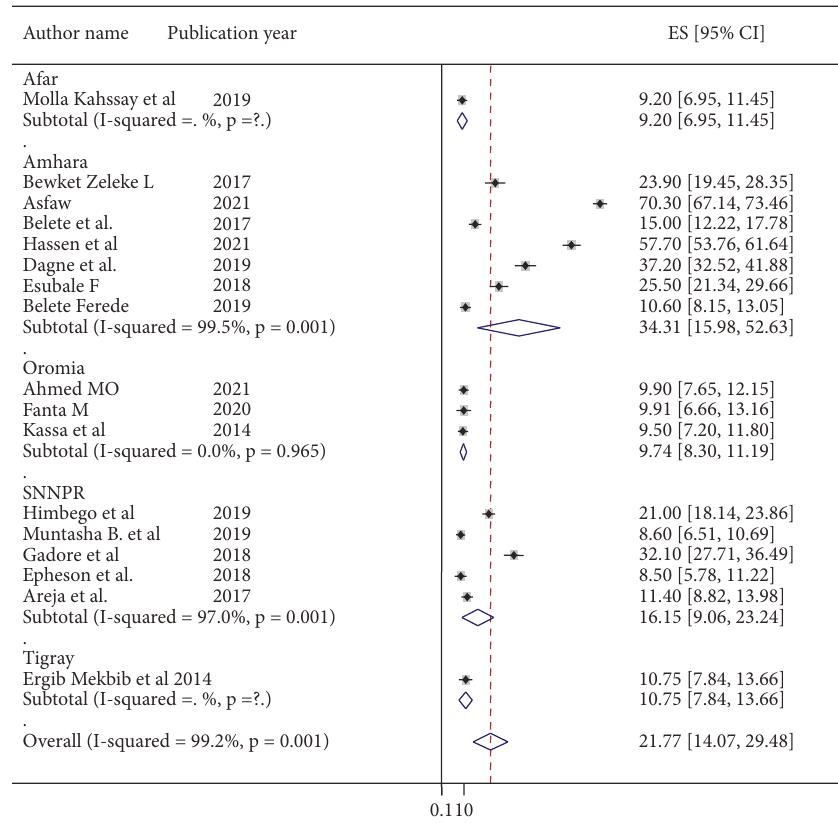
Figure 2: Forest plot displaying the pooled proportion of appropriate complementary feeding practices among mothers who had infants and young children aged between 6 and 24